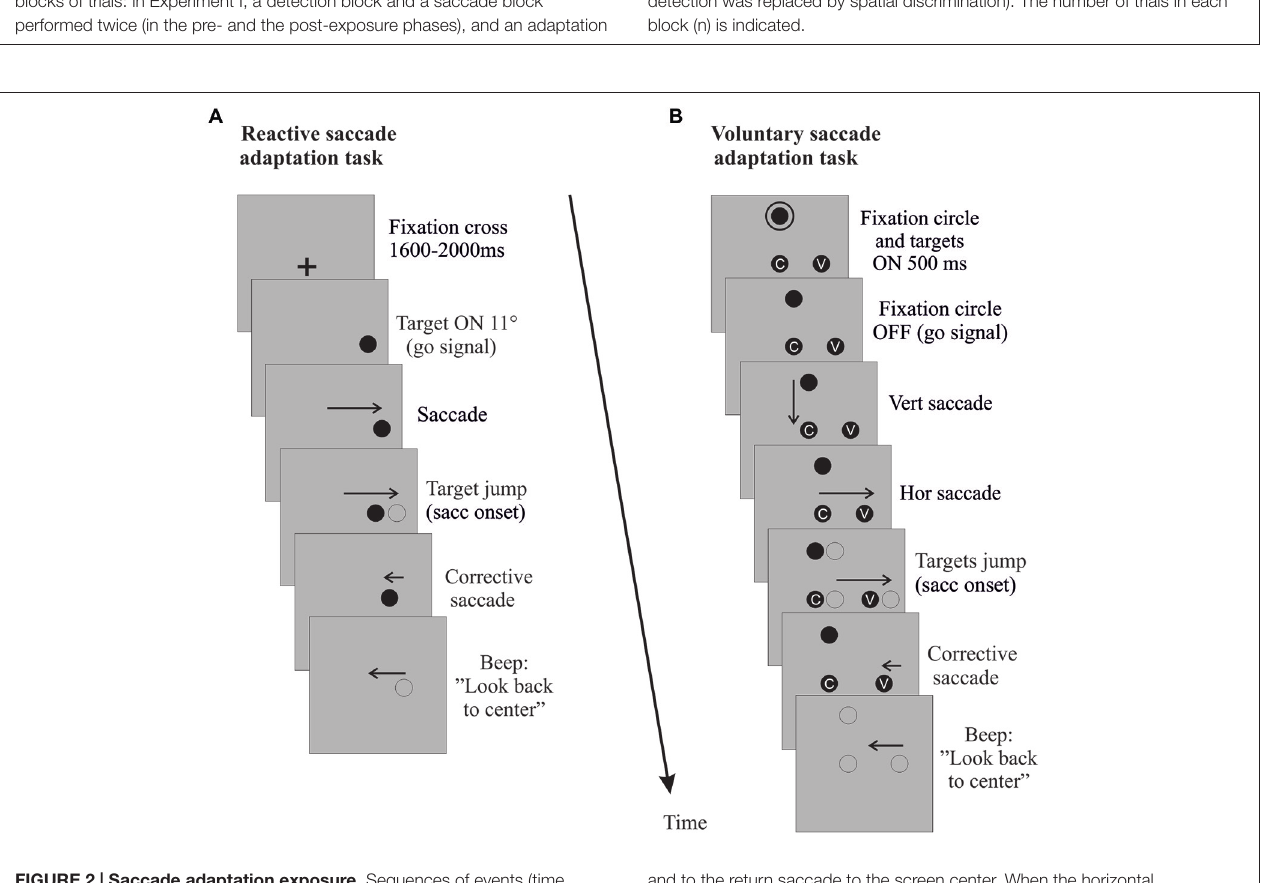
FIGURE 2 | Saccade adaptation exposure. Sequences of events (time running downward) in right hemi-field trials (left hemi-field trials not shown) are depicted for the reactive saccade adaptation task (A) and the voluntary saccade adaptation task (B). Vertical and rightward horizontal arrows correspond to the primary saccade toward the target. Leftward arrows correspond to the corrective saccade toward the shifted target